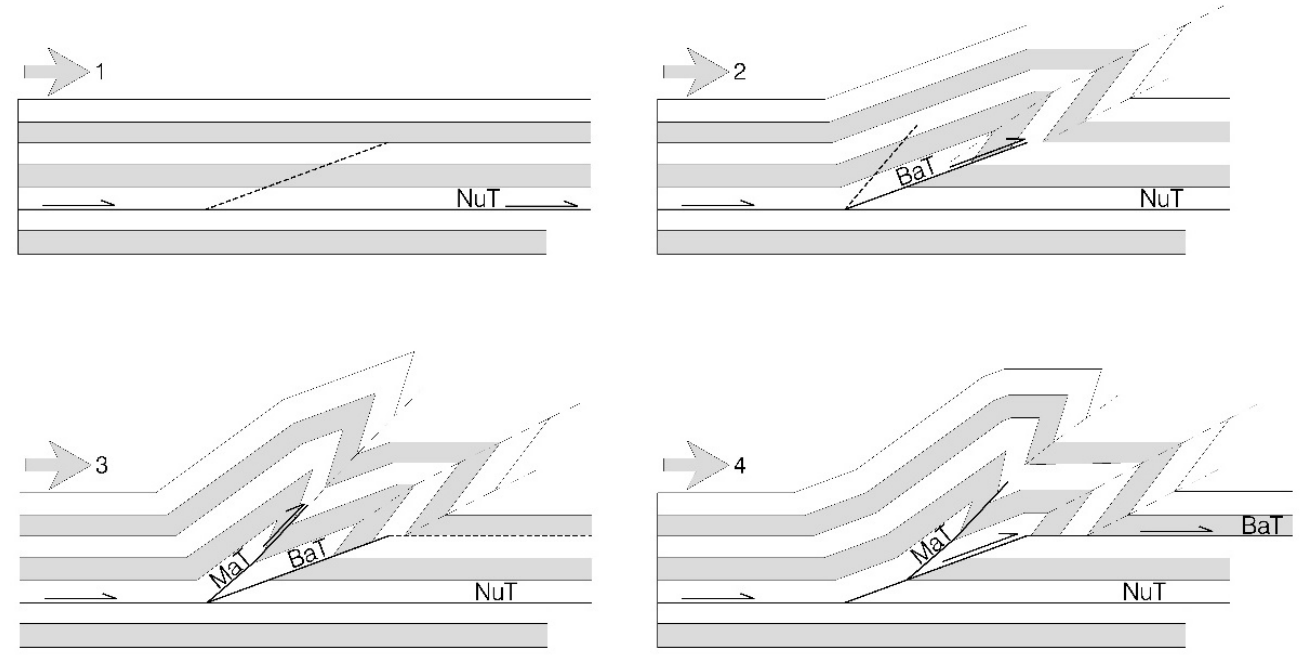
Figure 8. Cartoon showing the progressive deformation of the Black Angel tectonic unit interpreted as fault-propagation fold. NuT-Nunngarut Thrust, BaT-Black Angel Thrust, MaT-Mallak Thrust. The imbricate thrust is generated by propagation of the thrust tip along a ramp of undeformed strata (Black Angel and Mallak thrusts) and then transported by a thrust that has broken through onto an upper flat (Black Angel Thrust). The Black Angel pelite thus forms a parasitic Z-fold in the lower limb of a larger syncline in the footwall of the Mallak Thrust that, together with the Black Angel and Nunngarut thrusts, represent an imbricate thrust stack (Figure 8d). The ESE-trending axial planes of the folded marbles and pelite are tilted more than 60 ◦ towards the SW, establishing that the folds are related to simple shear passive folding with a SW-ward direction of tectonic transport. The latter agrees with the NW-SE trends of fold axes obtained from oblique images (Figure 7c) and with